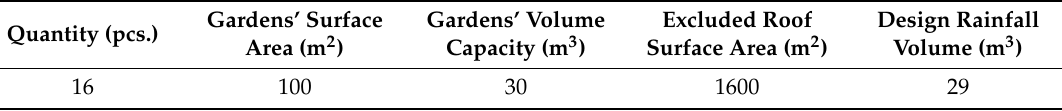
Table 8. Data summary for rain gardens.